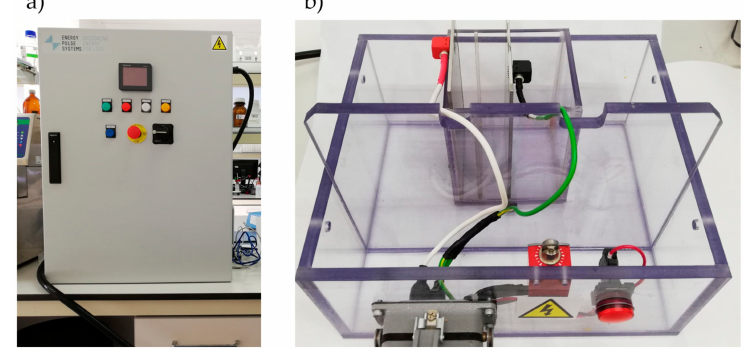
Figure 1. PEF generator ( a ) and the batch treatment chamber ( b